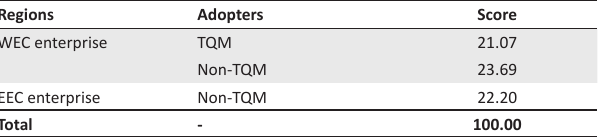
TABLE 3 : Business planning achievement percentages of respondents in the Western Eastern Cape and Eastern Eastern Cape regions.